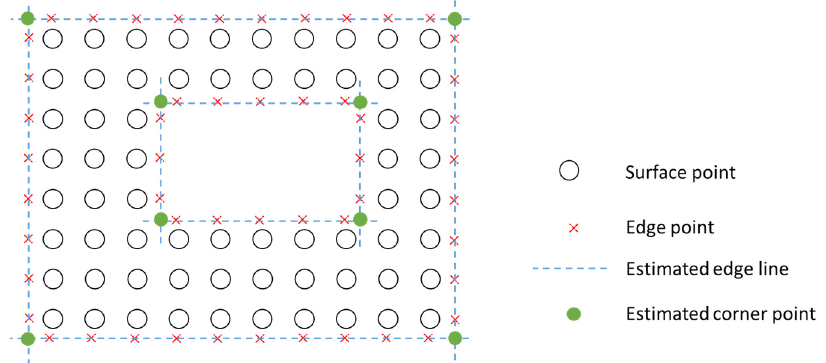
Figure 16. Extraction of estimated edge lines and corner points from surface points and edge points for the inspection of dimensions and locations of structural elements and openings.